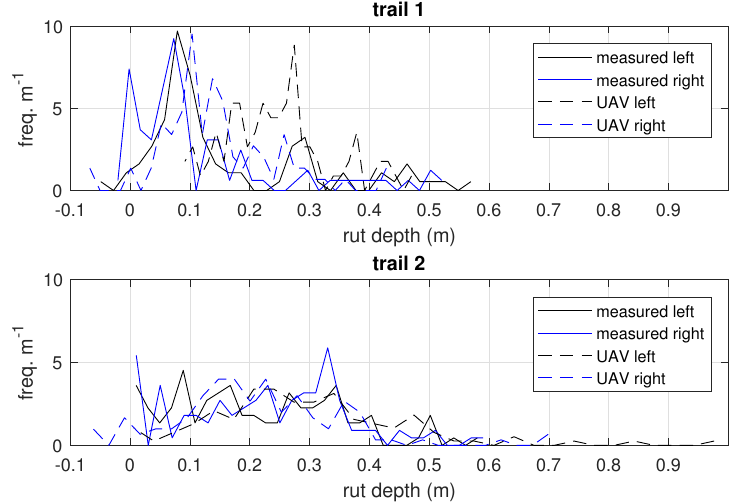
Figure 9. Trail 1 and 2 rut depth distributions over the rut length. The distributions of manually-measured rut depths and the rut depths extracted from the UAV photogrammetric point cloud. Each rut (left and right) of each trail has been plotted separately. Trail 1 has occasional deep depressions, whereas Trail 2 has a dominantly moderate rut depth.